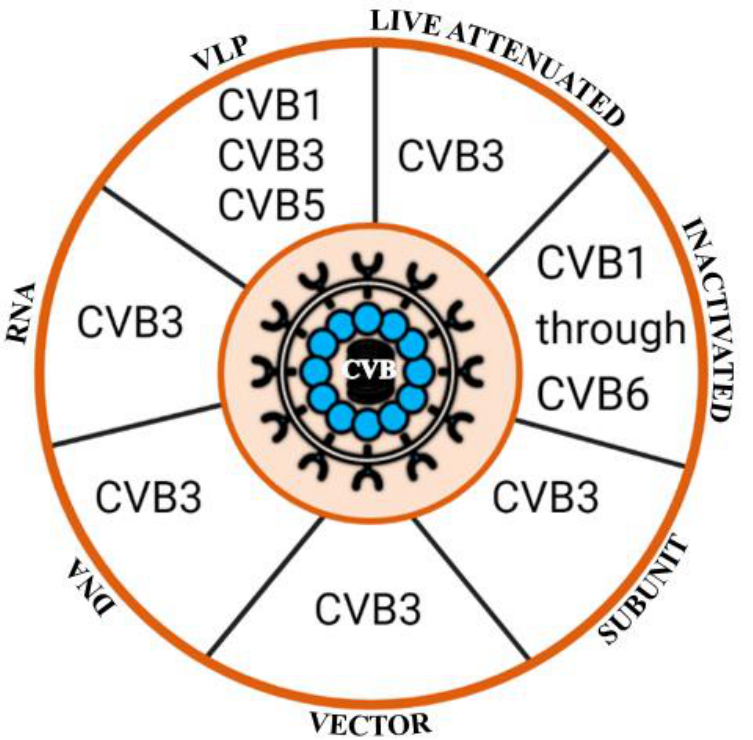
Figure 2. Experimental vaccines tested for various CVBs in the preclinical models. Several vaccine platforms shown with the upper-case text outside the big circle have been used to evaluate the efficacy of CVB vaccines in various preclinical models. While vaccines against CVB3 have been tested by using all the indicated approaches, killed vaccines have been tested for all six CVB serotypes, whereas VLP vaccines were tested only for CVB1, CVB3, and CVB5. The figure was created using